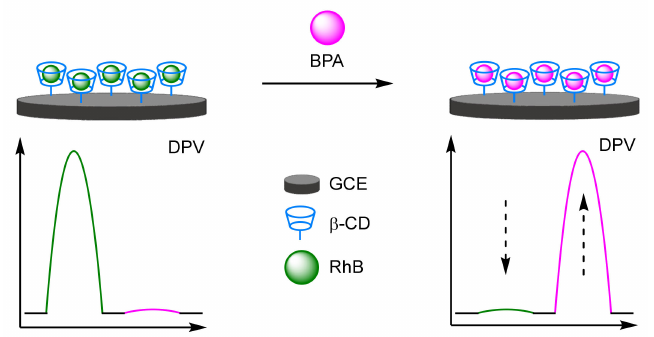
Figure 40. Schematic representation of a host–guest displacement assay for the detection of bisphenol A